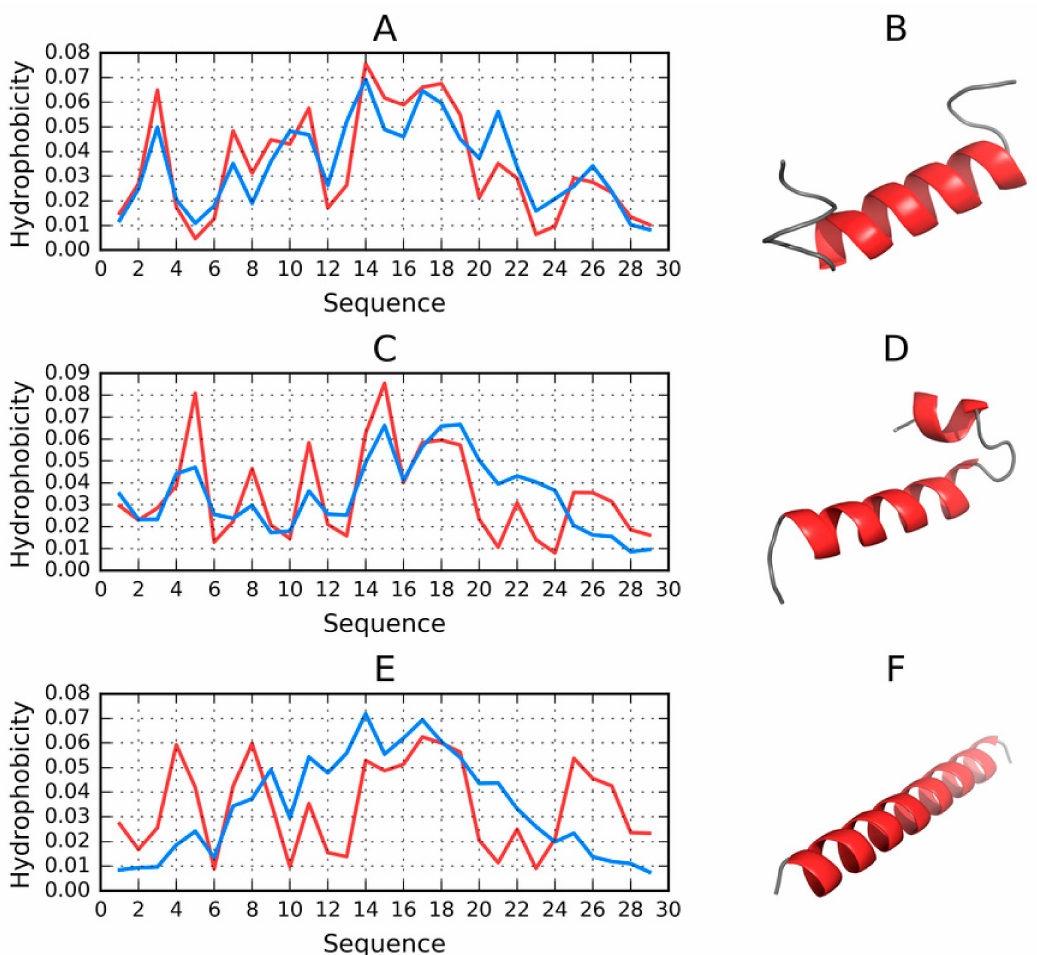
Figure 6. 3D visualizations along with theoretical (T, blue) and observed (O, red) hydrophobicity density distribution profiles for models involving the 1–30 fragment, produced by each software package and characterized by the lowest RD. ( A , B )—FOD_1_(053); ( C , D )—ITASSER_1_(3); ( E , F